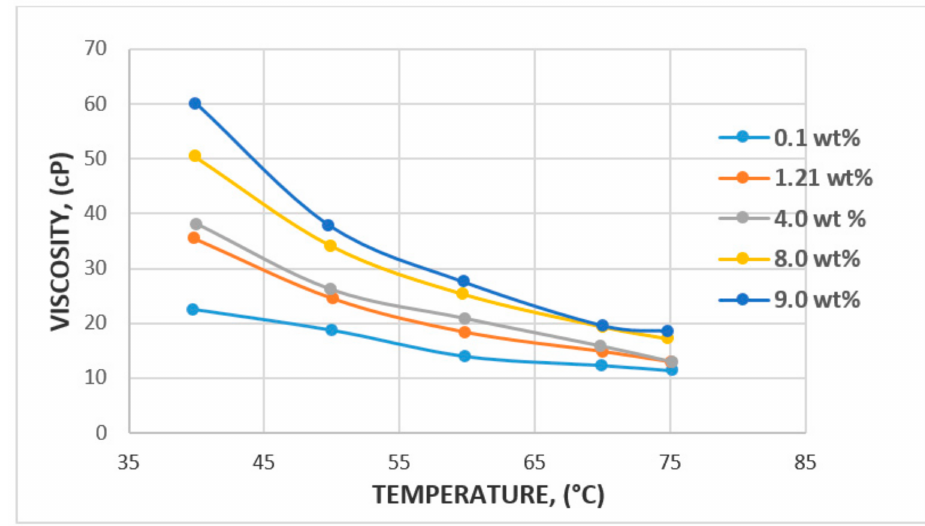
Figure 15. E ff ect of temperature on HPAM. Reprinted and modified from